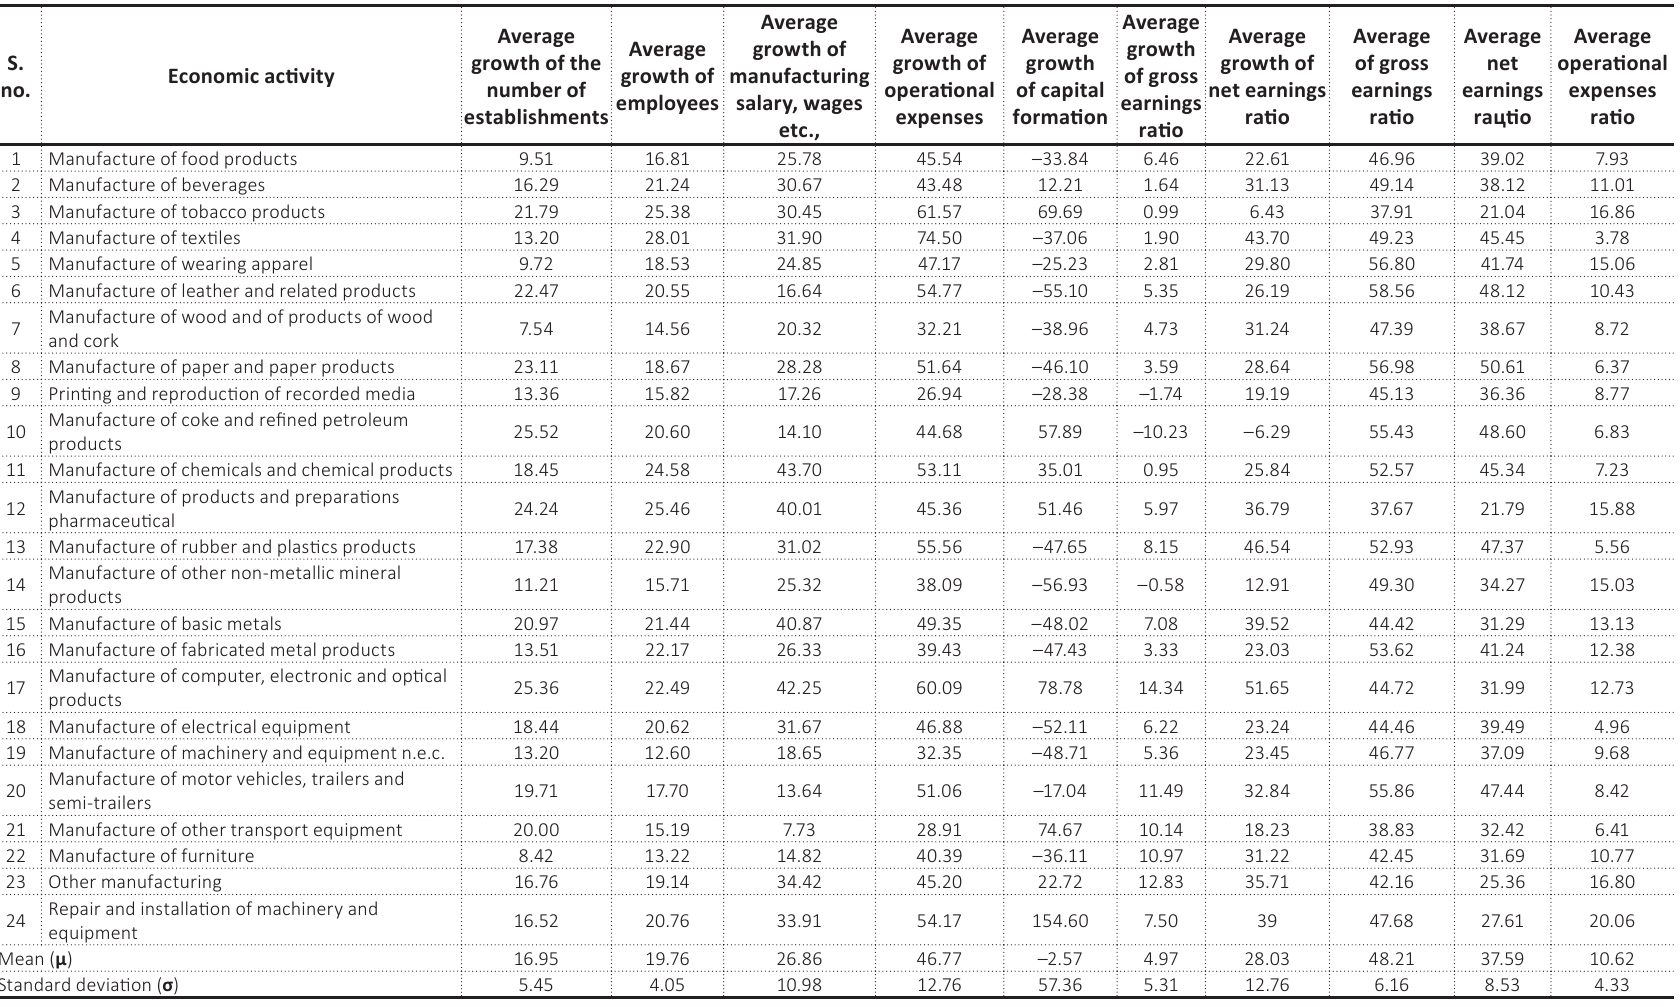
Source: General Authority for Statistics